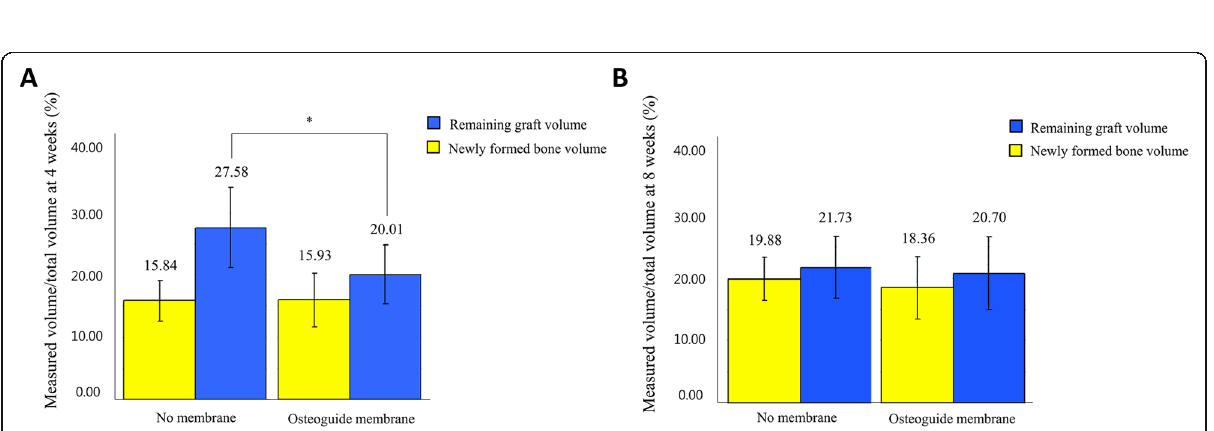
Fig. 3 Histologic analysis on the experimental and control groups. a At 4 weeks, newly formed bone volume was similar between the groups, but remaining graft volume was higher in no membrane group than osteoguide membrane group. b At 8 weeks, there was no significantly difference of newly formed bone and remaining graft volumes between the groups. * Krustal-Wallis Test is significant at the 0.05 level